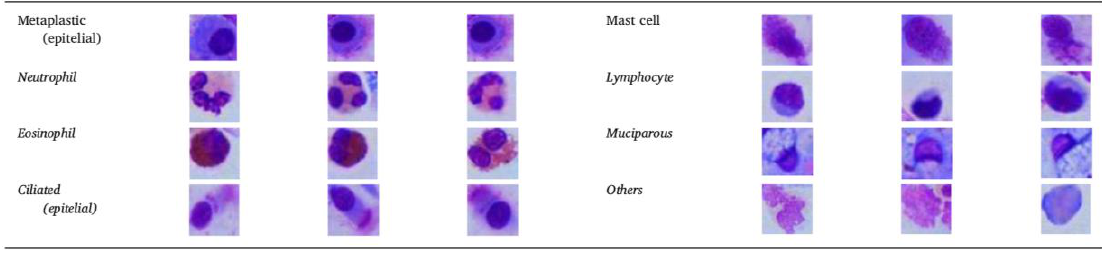
Figure 1. Nasal Figure 1. Nasal cells.